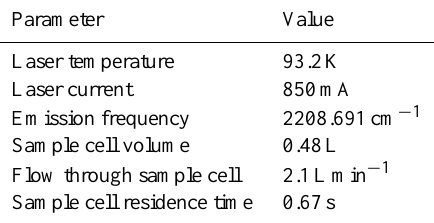
Table 2. Operating parameters of the